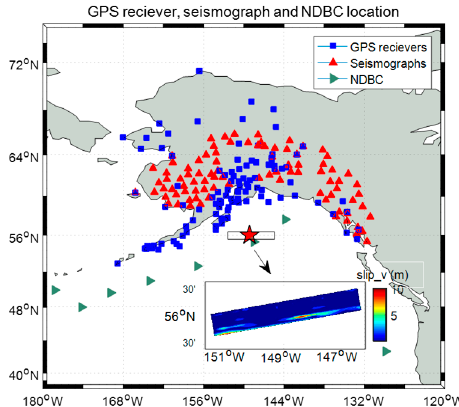
Figure 1. The distribution of GPS stations, seismographs and NDBC (National Data Buoy Center) stations around the epicenter. The red pentagram represents the epicenter. The square points represent GPS stations, the red triangles represent seismographs stations and green triangles represent NDBC stations. The sub-picture shows the finite fault of the earthquake (https://earthquake.usgs.gov/earthquakes). Strike-slip-faulting events of the size of the earthquake are typically about 230 × 30 km.